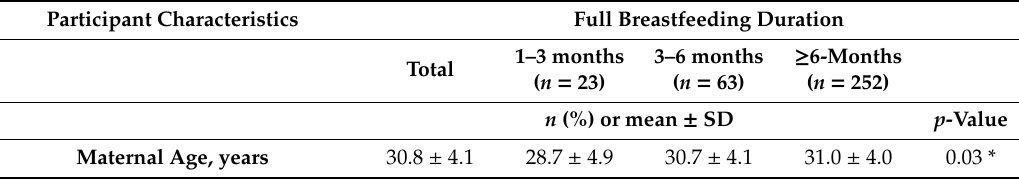
Table 1. Demographic, reproductive, and lifestyle characteristics of mother–infant dyads by full breastfeeding duration ( n =